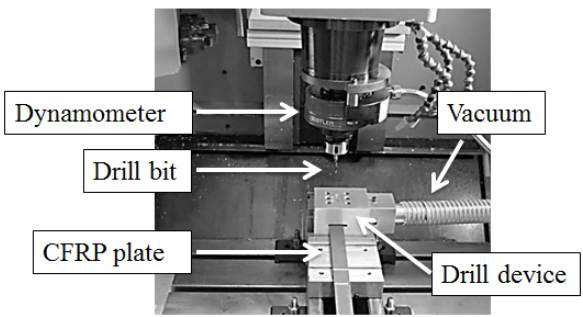
Figure 2. Experimental device for drilling tests.